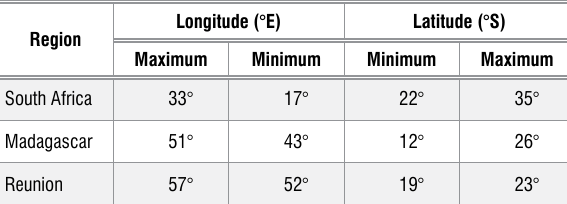
Geographic coordinates of the rectangle delineating the three